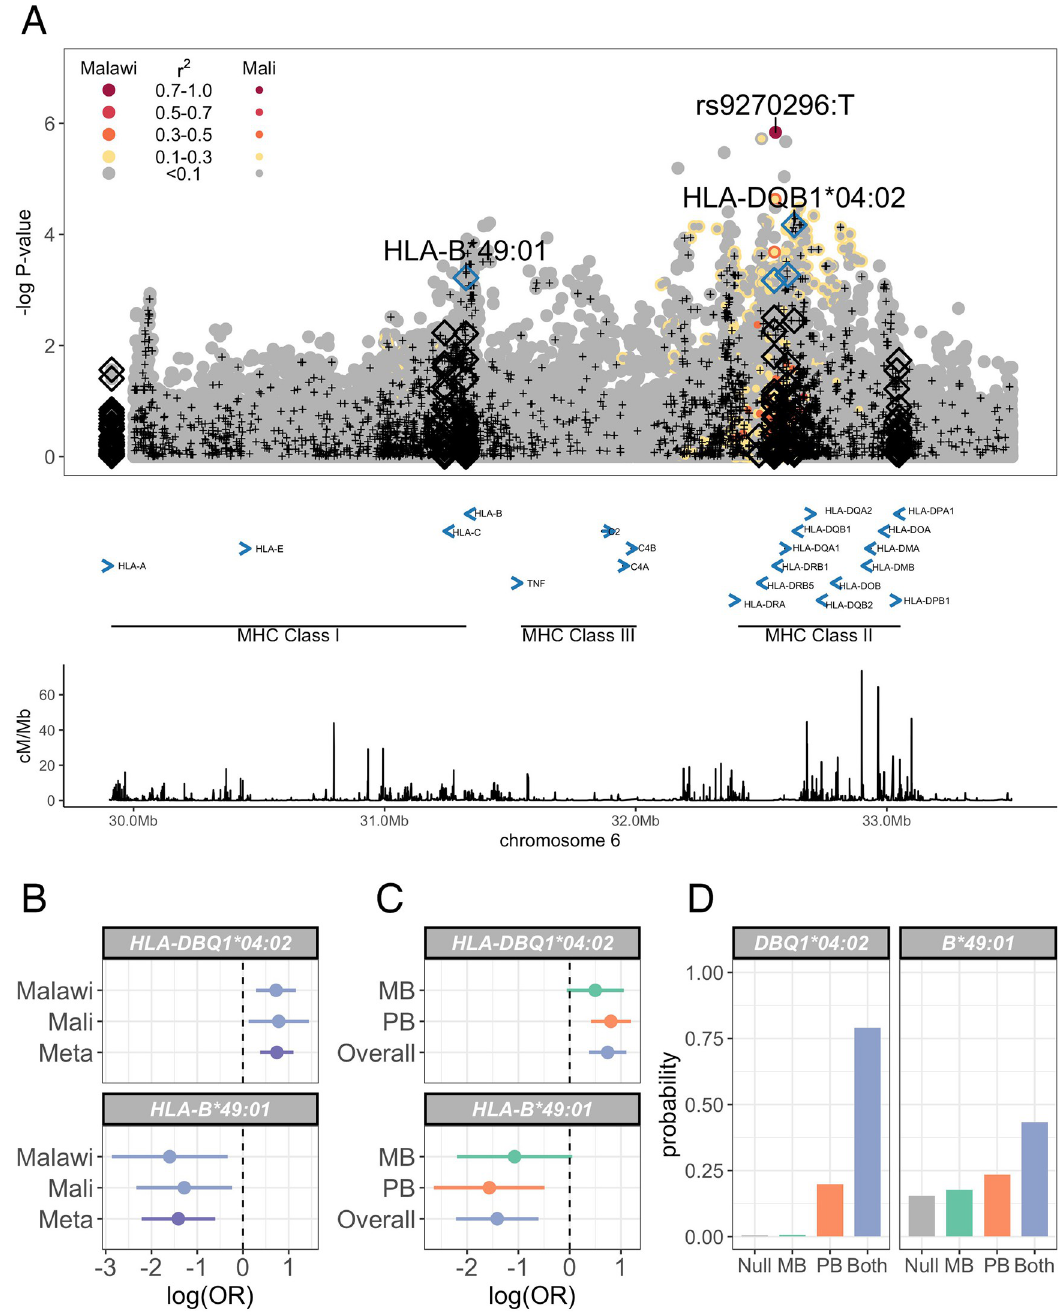
Fig 4. MHC leprosy association in Malawi and Mali. (A) Regional association plot of leprosy association across the HLA region. Association statistics represent a fixed-effects meta-analysis of additive association with disease in Malawi and Mali. SNPs are coloured according to linkage disequilibrium to rs9270926, and genotyped SNPs marked with black plusses. Imputed classical HLA alleles are plotted as diamonds, with significantly associated (FDR < 0.05) alleles highlighted in blue. (B) Log-transformed odds ratios and 95% confidence intervals of HLA-DBQ1 � 04:02 and HLA-B � 49:01 associations with leprosy in Malawi and Mali. (C) Log- transformed odds ratios and 95% confidence intervals of HLA-DBQ1 � 04:02 and HLA-B � 49:01 associations with leprosy stratified by multibacillary and paucibacillary disease. (D) Posterior probabilities of models of HLA-DBQ1 � 04:02 and HLA-B � 49:01 associations with leprosy: “Null”, no association with leprosy; “MB”, non-zero effect in multibacillary leprosy alone; “PB”, non-zero effect in paucibacillary leprosy alone; “Both”, the same non-zero effect is shared by individuals with multibacillary and paucibacillary leprosy.